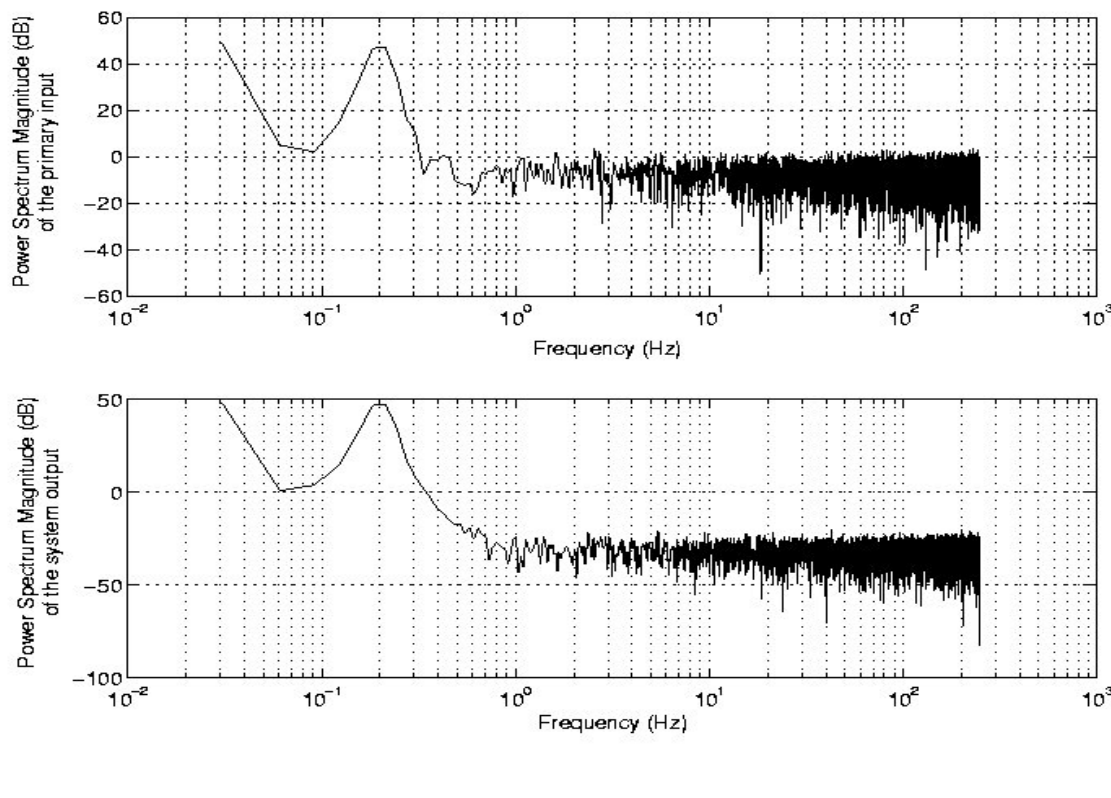
Figure 7. Power spectrum magnitude of the primary input and the system output